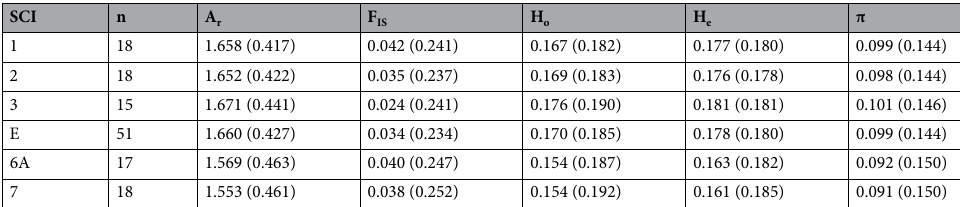
Table 1. Summary statistics for each scampi fishery management area (SCI) based on the mean values across 983 loci. SCI_E is composed of SCI_1, SCI_2 and SCI_3. Standard deviation is enclosed in brackets. SCI, scampi fishery management area; n, number of individuals; A r , allelic richness; F IS , inbreeding coefficient; H o , observed heterozygosity; H e , expected heterozygosity; π, nucleotide diversity.